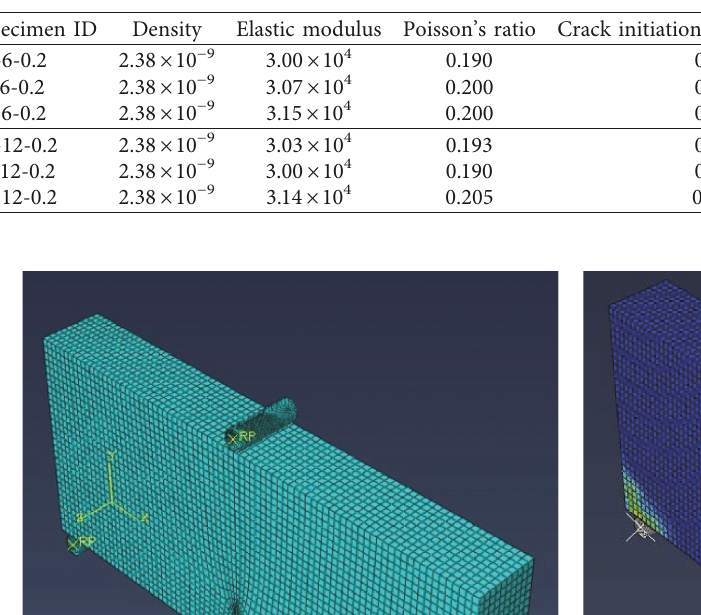
Figure 7: Crack propagation diagram. Table 11: BFRC model parameters.